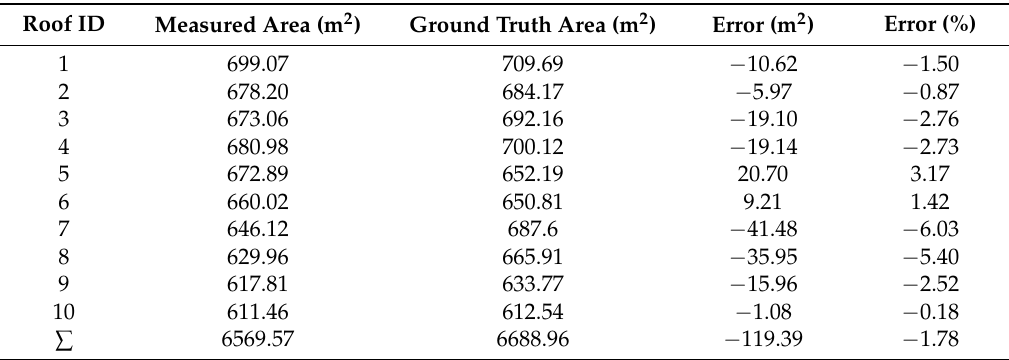
Table 4. Results for the Second Expansion data